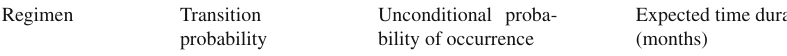
Table 7 Robustness checks. Source: author’s calculations